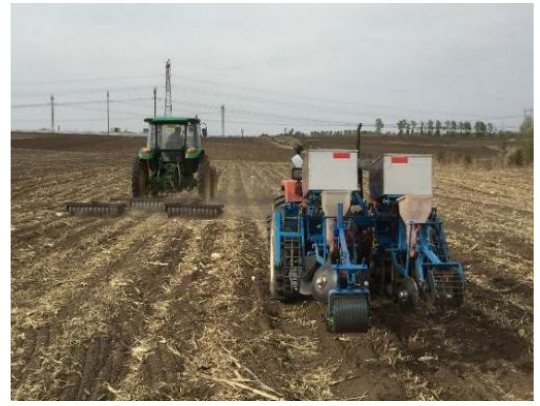
Figure 5. The field test.